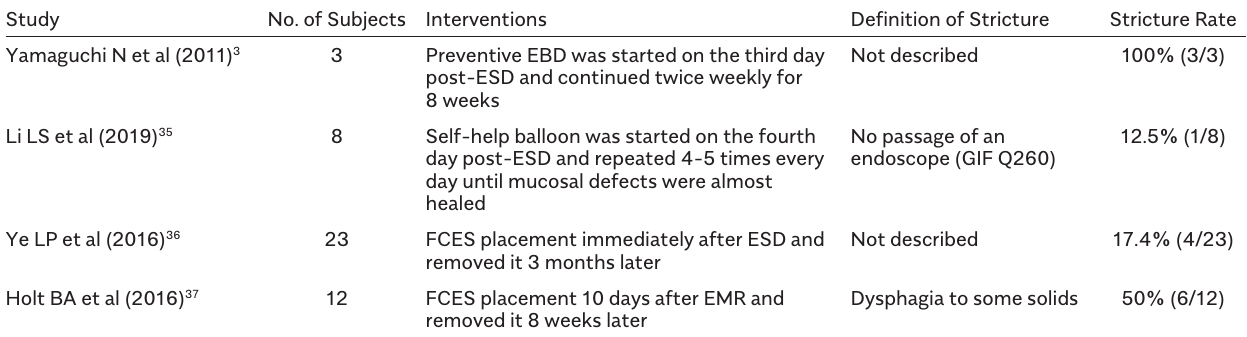
Table 2. Studies on EBD or Esophageal Stents for Prevention of Esophageal Stricture After Whole Circumferential Endoscopic Resection